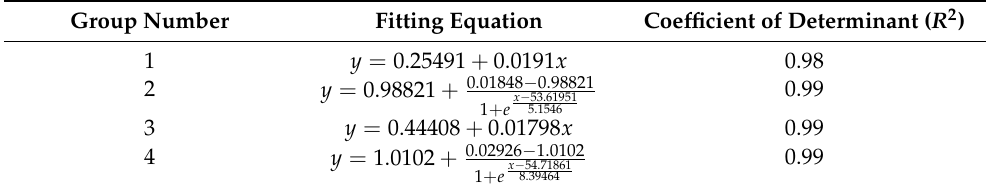
Table 2. Fitting relationship of gas mass fraction in the experimental group’s caving zone and fracture